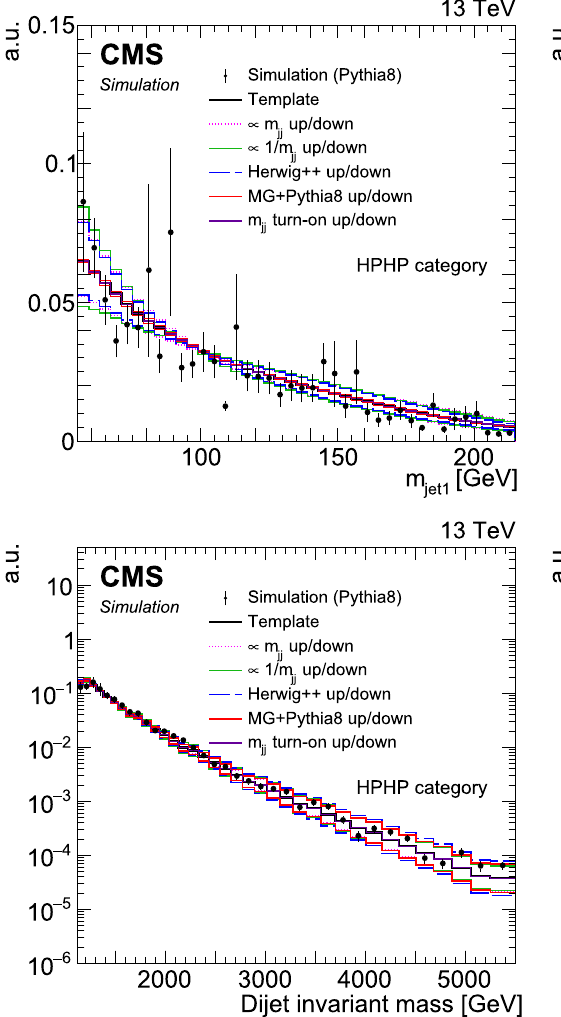
(upper) and m jj (lower). The projection on m jet2 is omitted since it is equivalent to the m jet1 projection except for statistical fluctuations. The pdfs and the simulations shown are normalized to unity. The normal- ization uncertainty of 50% is not shown. The distributions for 2016 simulations are